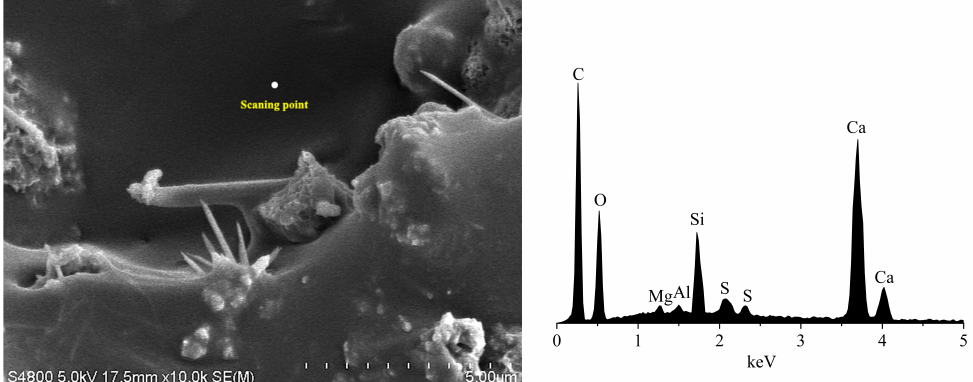
Figure 7. Chemical composition of CRME without cement.